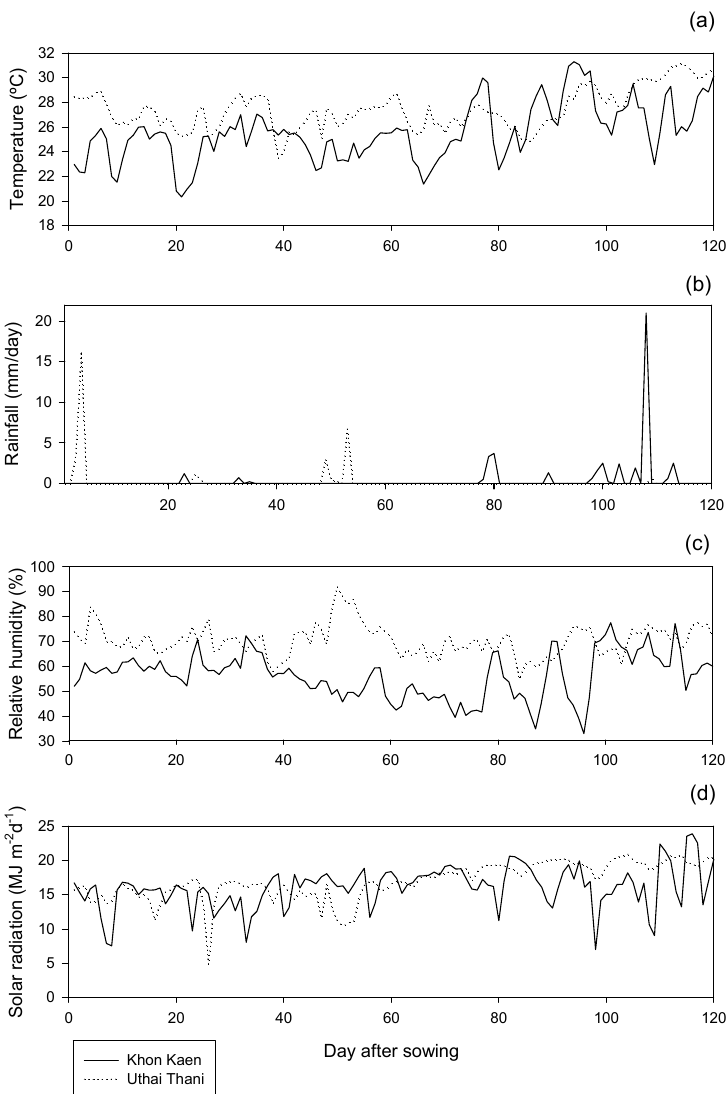
Figure A1. ( a ) Temperature, ( b ) rainfall, ( c ) relative humidity, and ( d ) solar radiation at Khon Kaen and Uthai Thani.